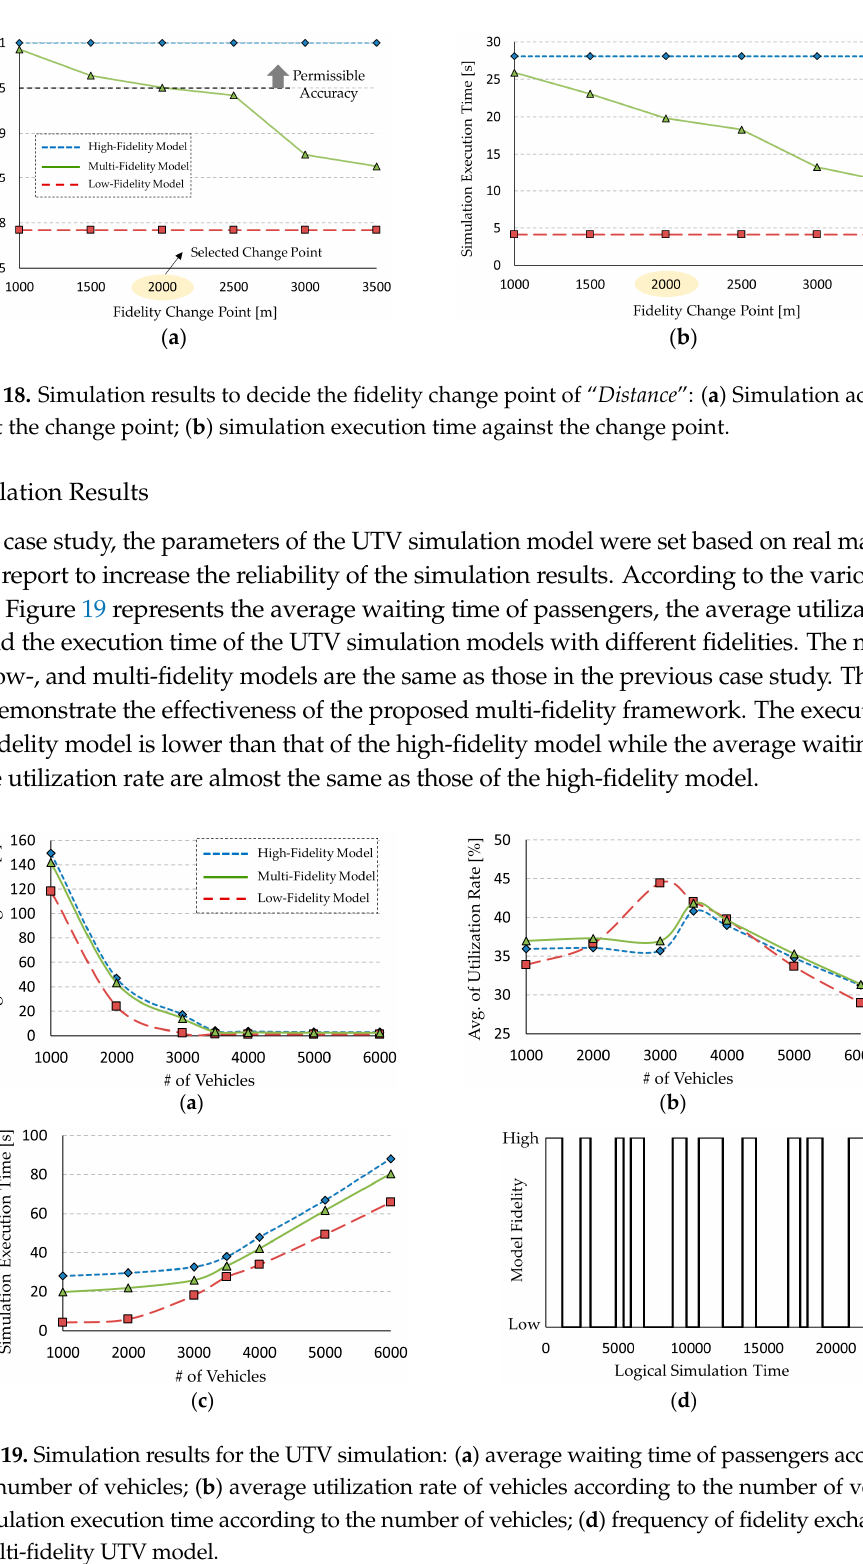
Figure 18. Simulation results to decide the fidelity change point of “ Distance ”: ( a ) Simulation accuracy against the change point; ( b ) simulation execution time against the change point.